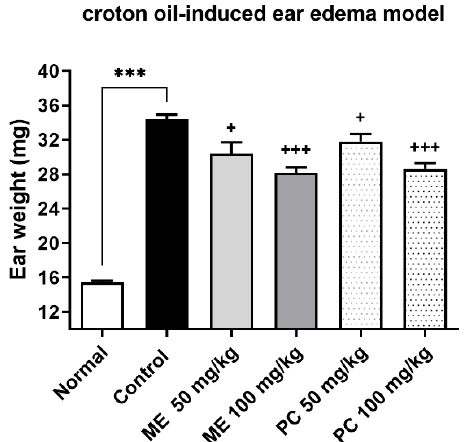
Figure 4. The anti-inflammatory effect of ME and PC administered orally in the ear edema model. ME or PC was orally administered to the mice at 50 and 100 mg/kg. The weight of the ear was measured at 1 h after treatment. Error bars represent SEM ( n = 5) (one-way ANOVA for multiple comparisons, Normal vs. Control p < 0.0001, Control vs. ME 50 mg/kg p = 0.0150, Control vs. ME 100 mg/kg p < 0.0001, Control vs. PC 50 mg/kg p = 0.0329, Control vs. PC 100 mg/kg p < 0.0001). *** p < 0.001; + p < 0.05, +++ p < 0.001.